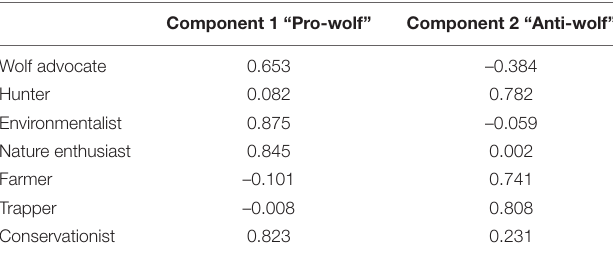
TABLE 1 | Principal component analysis of putative identity of wolf stakeholders in Minnesota, United States: Rotated component matrix (varimax rotation with Kaiser